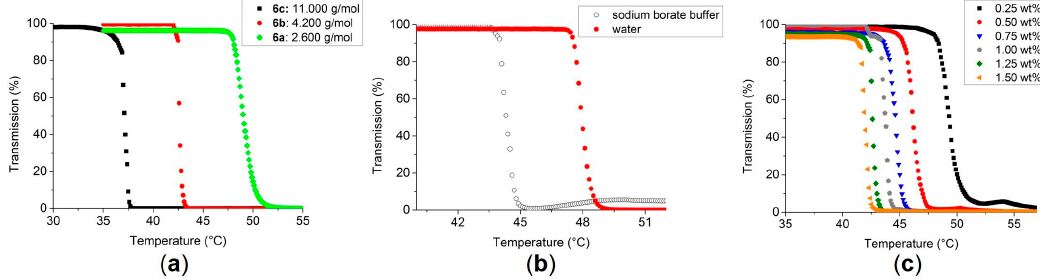
Figure 3. LCST measurements for the POx as 1 wt % solutions: ( a ) influence of the molecular weight for the polymers 6a , 6b and 6c ; with an increasing molecular weight, the LCST is decreasing; ( b ) sodium borate (50 mmol/L, pH = 9.0) decreases the LCST of P i PrOx 6a (2600 g/mol) by nearly 4 K from 47.5 down to 43.6 °C; the curve with the filled symbols (red) refers to a measurement in water, whereas the curve with the open symbols (black) refers to a measurement in buffer; ( c ) with an increasing concentration, the LCST for polymer 7 (3100 g/mol) is shifted to lower values and can be tuned between 48.2 ˝ C (0.25 wt %) and 41.3 ˝ C (1.50 wt %) within the tested concentration